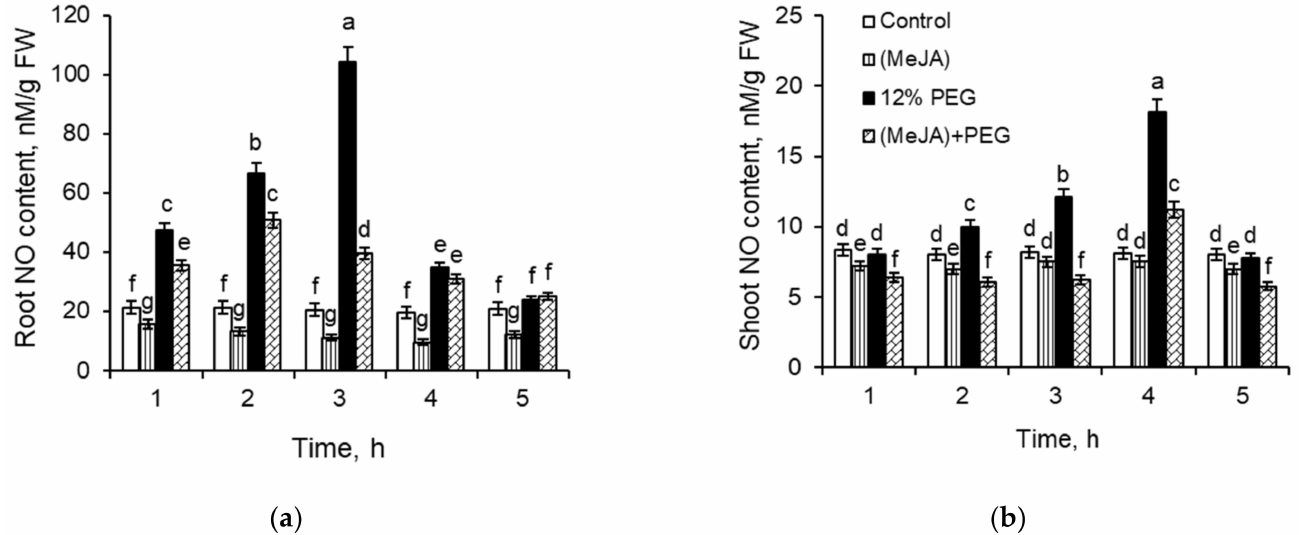
Figure 2. The level of NO in roots ( a ) and shoots ( b ) of 6-day-old wheat seedlings pretreated with 10 − 7 M MeJA for 24 h and under subsequent 12% PEG treatment for 5 h. Data are the mean of three replicates; different letters show significant difference at p ≤ 0.05 and bars indicate ± SE (n = 30).